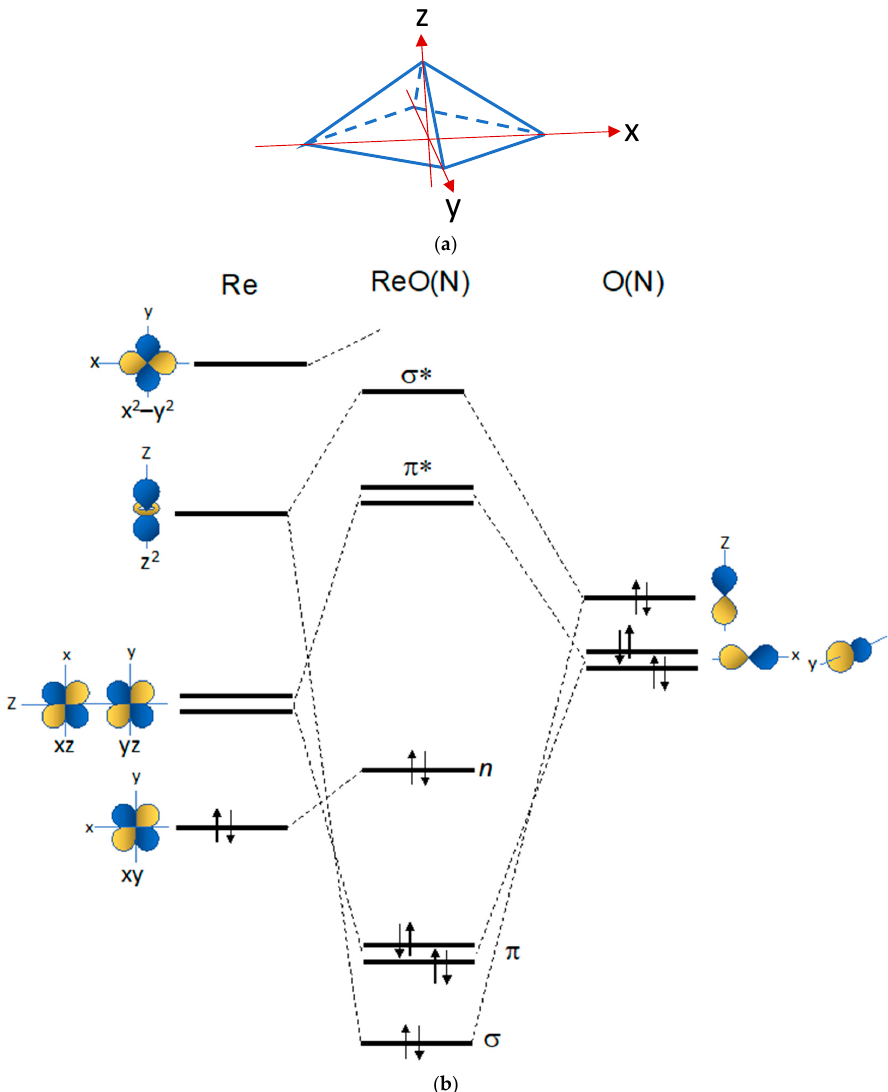
Figure 3. ( a ) Square pyramidal geometry ( sp ). In this geometry, the rhenium atom lies at the centre of the basal square-plane, and the heteroatom (O or N) spans the apical position of the square pyramid. ( b ) Qualitative energy level diagram of frontier molecular orbitals (FOs) for the [Re ≡ N] 2+ and [Re ≡ O] 3+ inorganic functional groups in a sp geometry (energy is reported on the vertical y -axis).